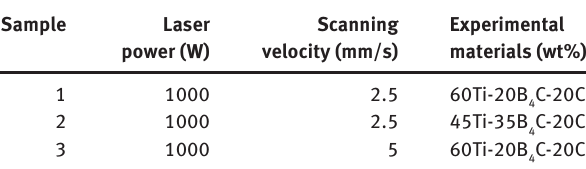
Table 1 Experimental parameters of laser alloying process.